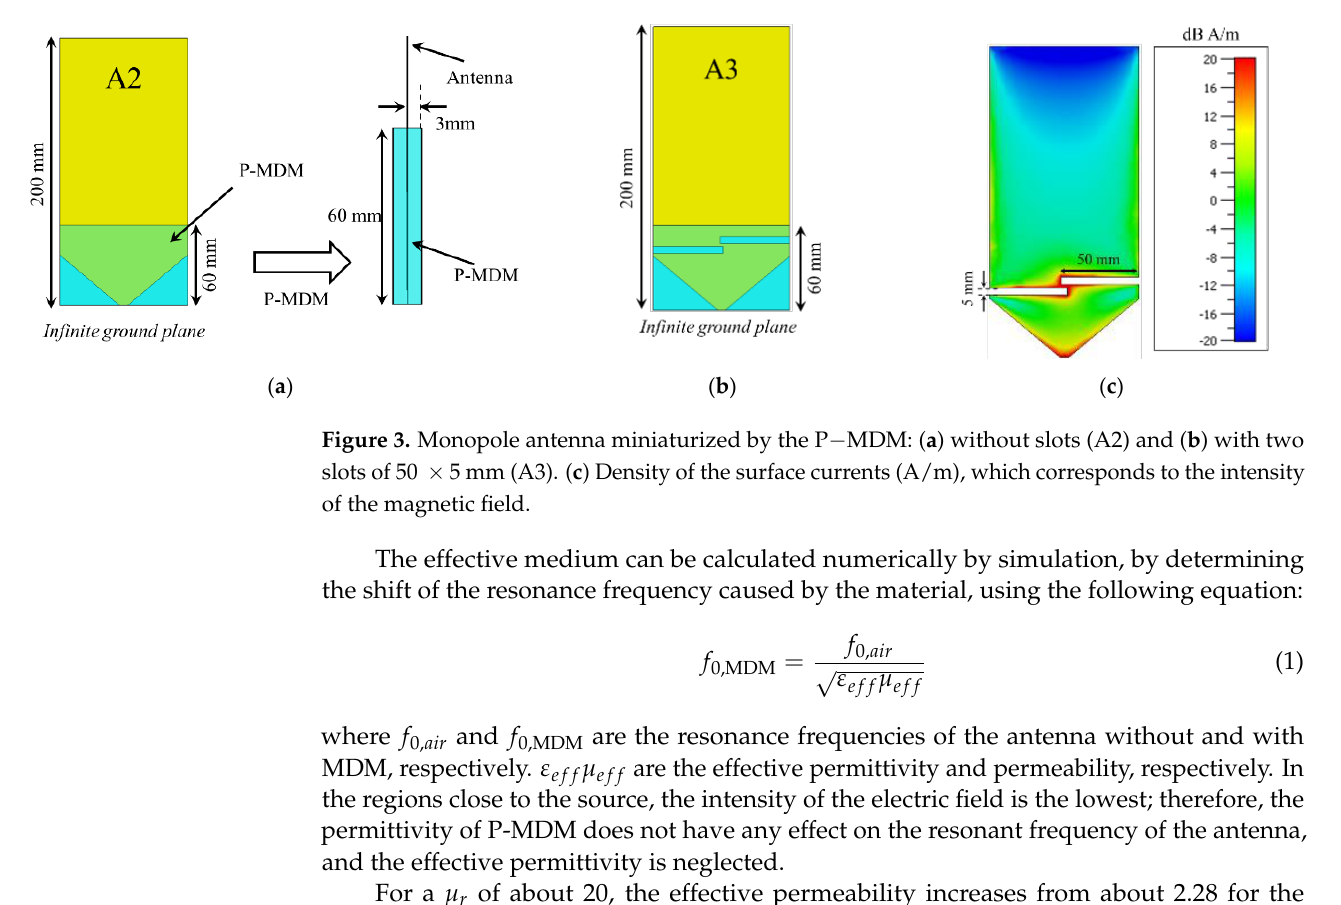
Figure 3. Monopole antenna miniaturized by the P − MDM: ( a ) without slots (A2) and ( b ) with two slots of 50 mm × 5 mm (A3). ( c ) Density of the surface currents (A/m), which corresponds to the intensity of the magnetic field. Figure 4. Effective medium in function of the relative permeability for both miniaturized antennas: without slots (A2) and with two slots (A3).